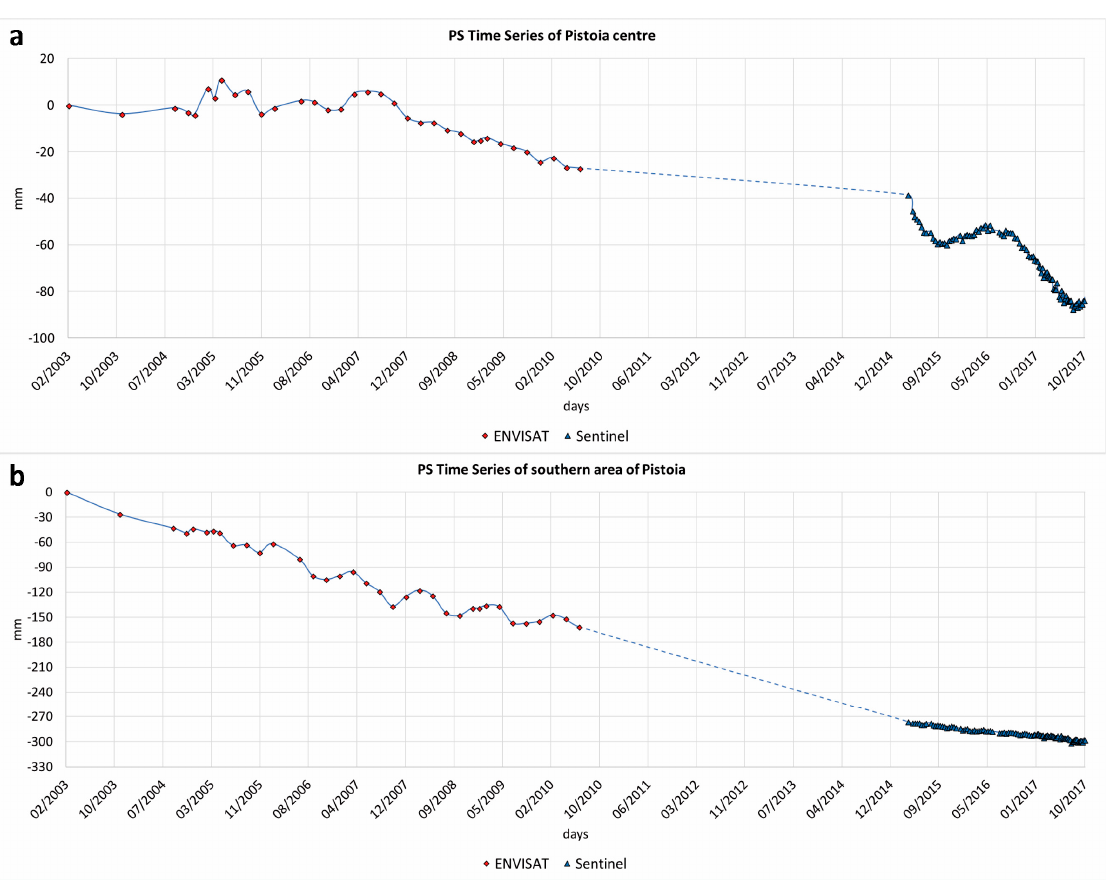
Figure 8. Time series of the two PS sites in the two areas affected by subsidence in Pistoia Province: city centre of Pistoia ( a ) and southern area of Pistoia ( b ).